Question: What form of chart is displayed?
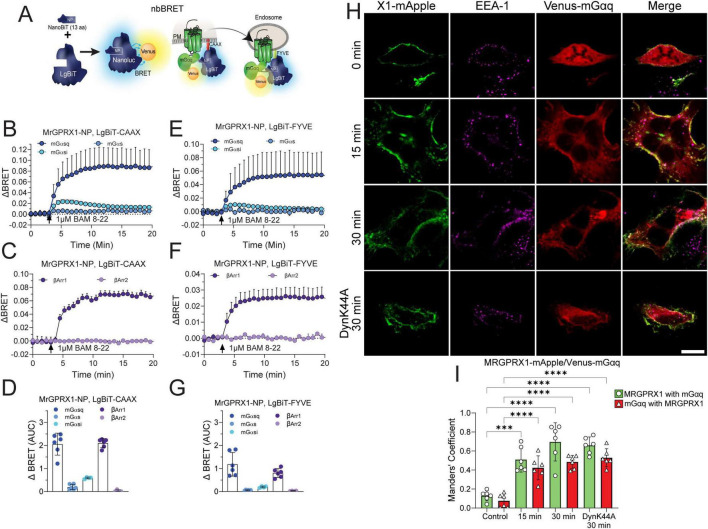
Answer: line